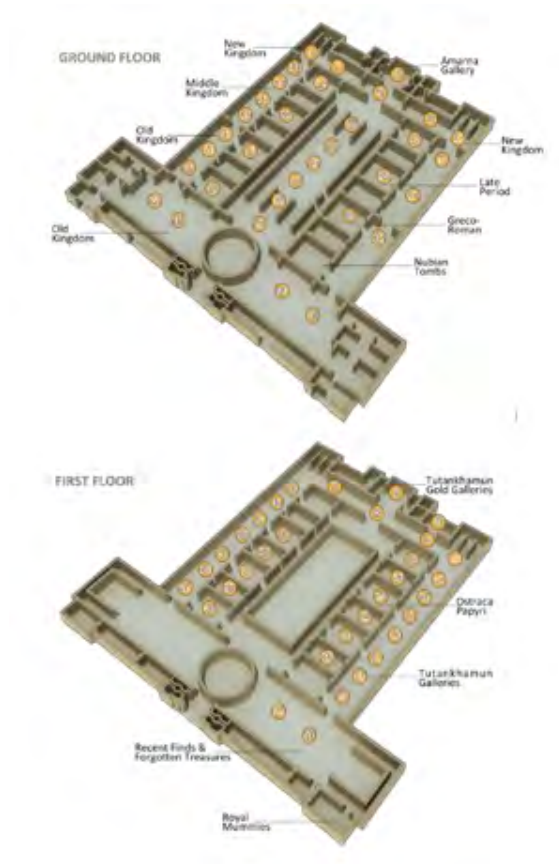
Figure 4. The Egyptian museum isometric